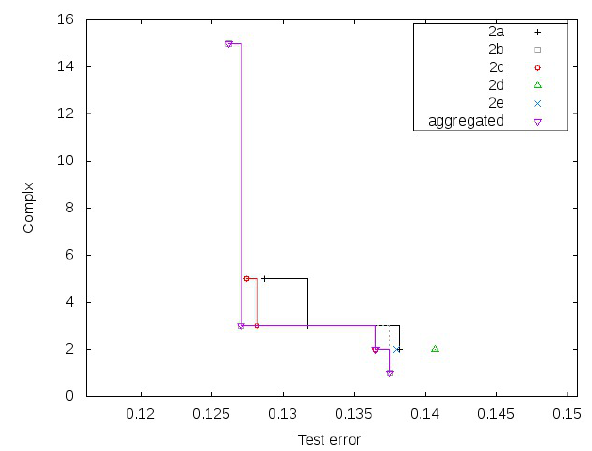
Fig. 9. The Pareto front approximations obtained for magic using the five fitness functions. Objective 1 stands for test error and objective 2 for complexity. The pseudo-optimal Pareto front is also drawn for